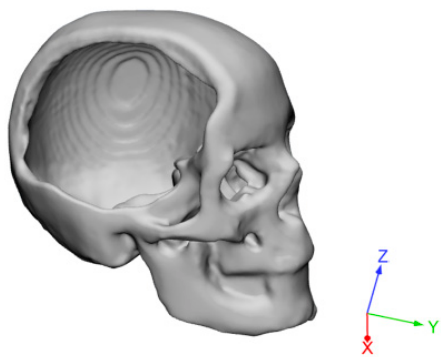
Figure 2. Three-dimensional reconstruction of a skull with a large cranial defect. The images were analyzed starting from a previous 3D scanning process [1].